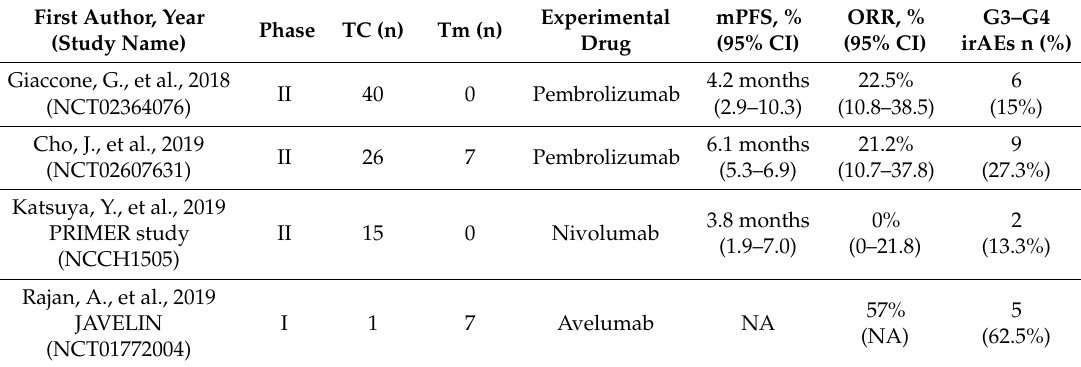
Table 1. Published clinical trials of IO monotherapy in thymic epithelial tumor (TET)